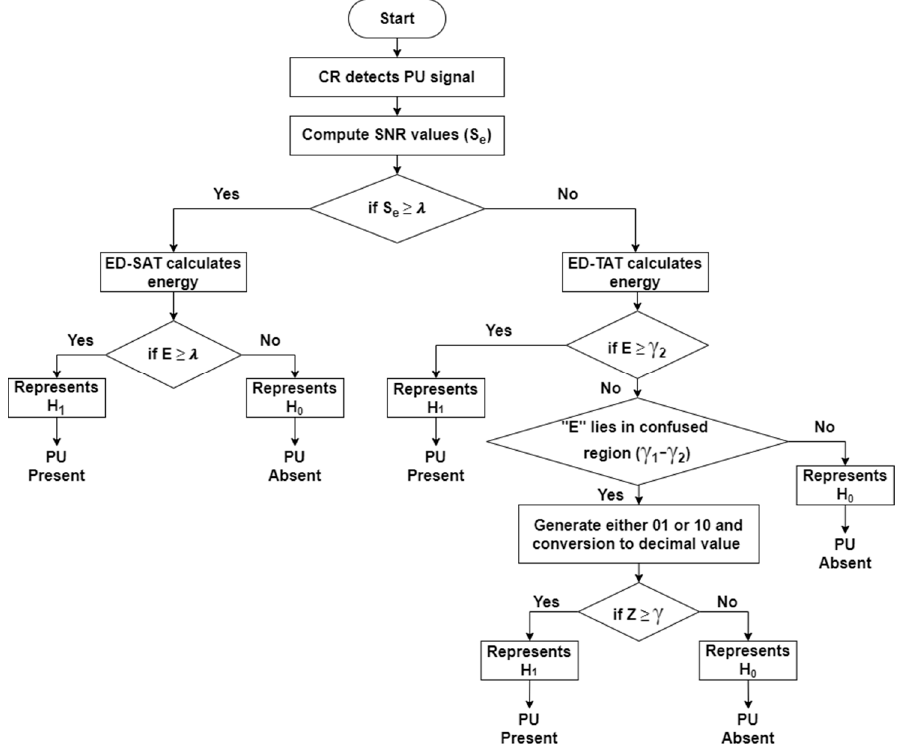
Figure 2. Flow chart of the proposed intelligent sensing technique.